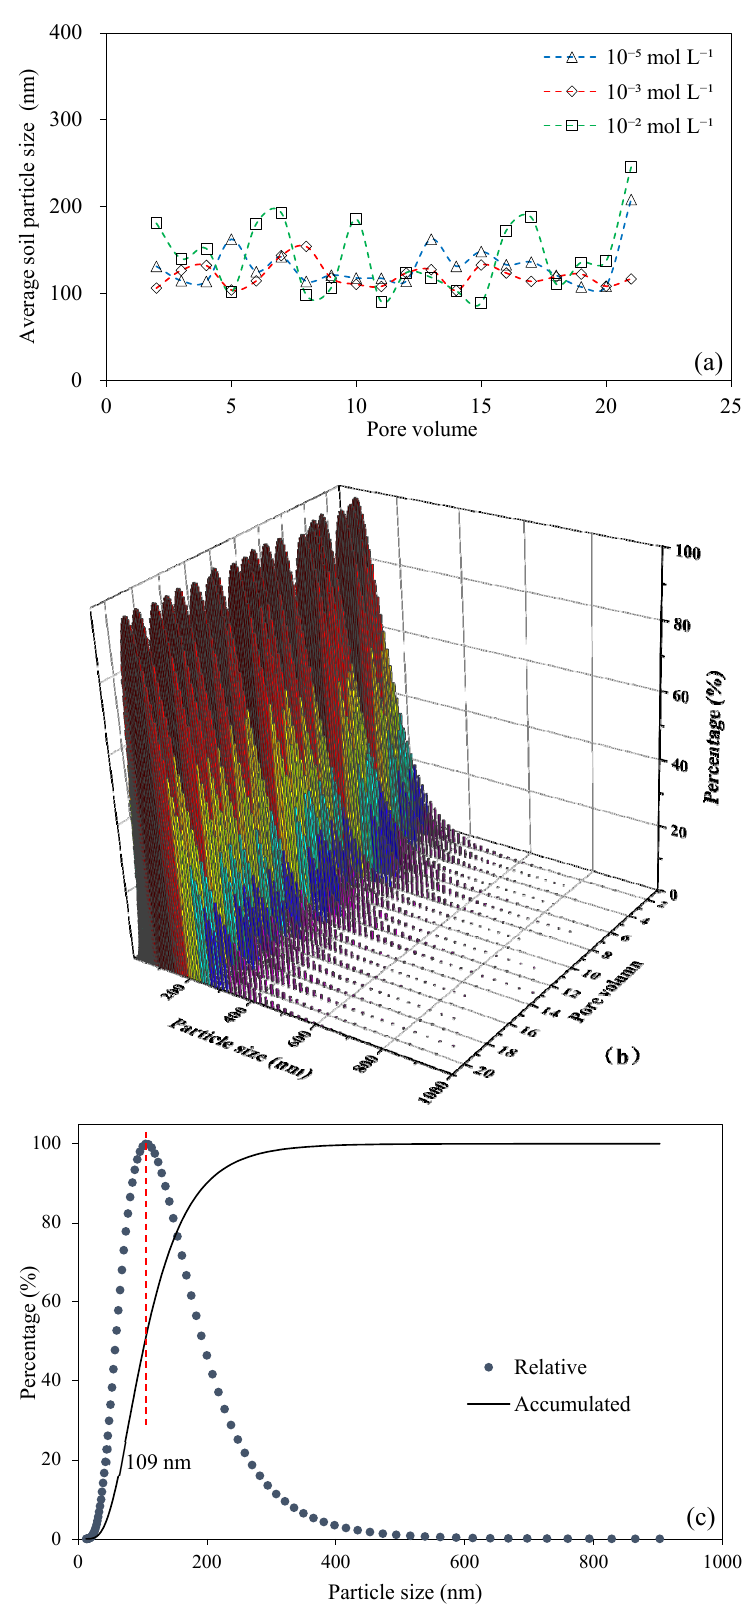
Figure 5. Average particle size variation of released particles with pore volume ( a ); the whole particle size distribution of the effluents under 10 − 3 M ( b ); particle size distribution at the 2nd PV ( c ). The release, filtration, and deposition also affected the transport of the disaggregated particles [51]. For an individual particle, the repulsive pressures dominated the interaction with other particles. However, at the same time, the negatively charged medium surface hardly provided available deposition sites. Therefore, the effect of deposition was limited. Physically, the straining process of soil particles could happen when the size of the parti ‐ cles was larger than the pore throats. The value 0.0017, a ratio of particle diameter to me ‐ dium diameter, was commonly chosen as the critical straining threshold to approximately rate the influence of straining [52]. Here, we took the minimum size of the packed soil aggregates of 0.50 mm for estimation. The computed result illustrated that the maximum particle size which could pass through the soil column was 850 nm. Considering a minute quantity of large particles was detected, the very release process might play a certain role in the size of released particles. The reason might be that the interactions of the surround ‐ ing large particles stabilized the particle which maintained the overall structure of soil aggregates. Therefore, the particle size of released particles was largely attributed to the filtration and release process. There was no evidence that the electrostatic repulsive pressure had a significant sep ‐ aration or diversion effect on the clay mineral composition of the disaggregated soil par ‐ ticles. As observed, there was hardly any micro aggregate, but there were individual par ‐ ticles in the effluents. The observation was consistent with the previous study [53]. After collecting and oven drying the disaggregated soil particles, the comparison of released particles and packed aggregates was demonstrated in Figure 6. Although there were ob ‐ vious differences in morphology, both soils were similar in elemental composition. The most abundant elements (Si, O, Al) accounted for more than 70% of the total, which was also the main elements of clay minerals. Similarly, the XRD results in Figure 6d indicate the clay minerals of the two were illite, vermiculite, kaolinite, and montmorillonite in de ‐ scending order by content. It can be confirmed that all the soil particles released from the breakdown of aggregates were soil elementary particles, and the mineral composition of released particles was highly correlated to the raw soil [7].